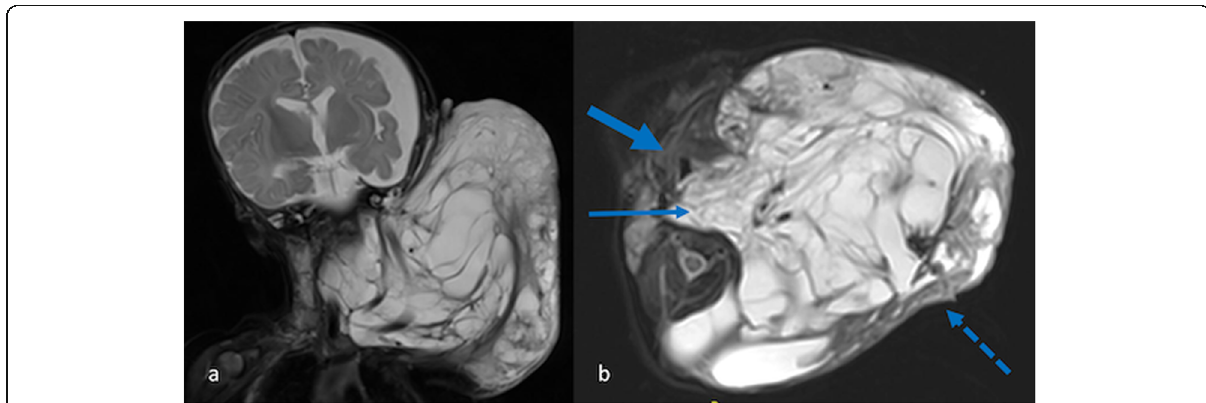
Fig. 11 Lymphatic malformation in a 2 day old male. a coronal and b axial T2 weighted MR images delineate the complex lesion causing marked distortion of the anatomy of the neck. On the axial image, the prevertebral disease (thin arrow) displaces the trachea (thick arrow); this is the area that should be targeted with sclerotherapy to improve the child ’ s respiratory status. The more bulky, superficial disease (broken arrow), although tempting to treat, is of little clinical consequence at this